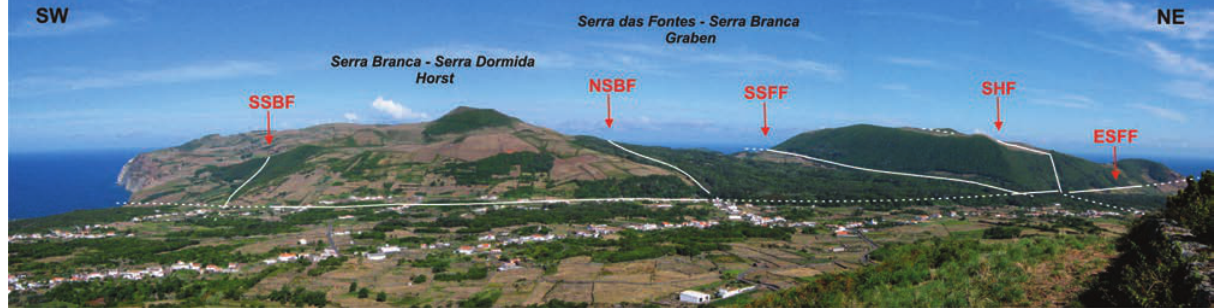
Figure 7. Photograph of fault scarps in the central region of Graciosa Island viewed from the SE. Continuous white lines indicate fault traces; dashed white lines mark hidden fault traces. Fault legend as in Figure 6.